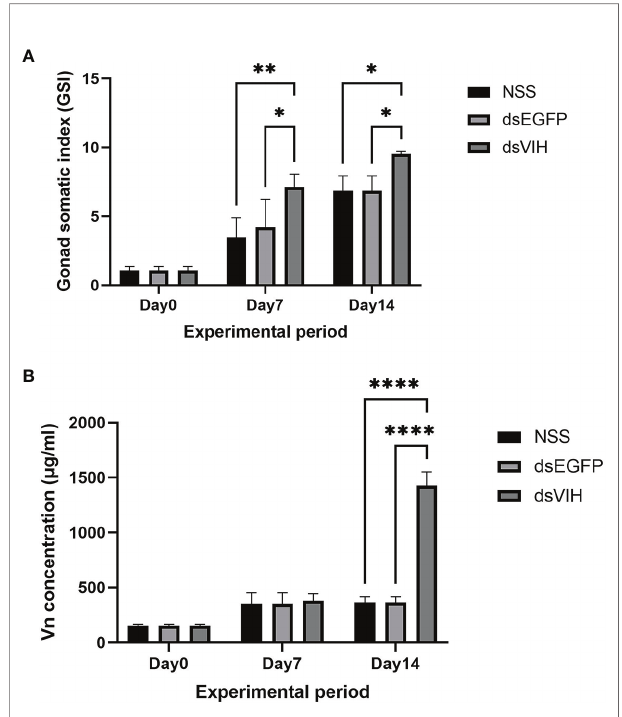
FIGURE 5 | The effects of dsRNA-VIH on (A) GSI and (B) hemolymph Vn level of the dsRNA-VIH treated crabs and control crabs at day 14 and day 28 post- injection. Bars represented the standard error of the mean (SEM). * p < 0.05 ** p < 0.005, and **** p <